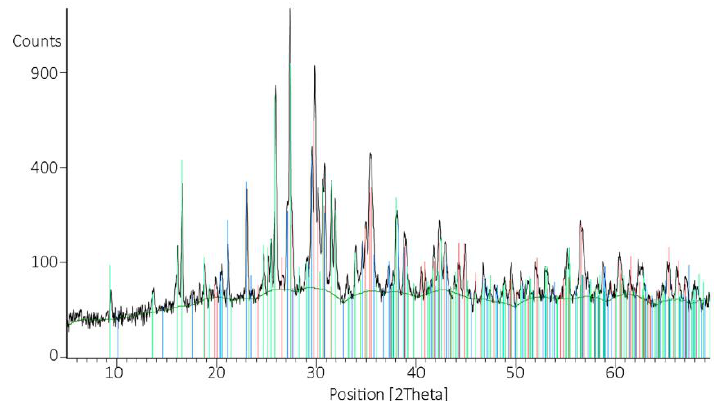
Figure 9. X-ray diffraction results from sample 9113B. The diffraction maxima allow the following crystalline phases to be identified: leucite (L) (green), nepheline (N) (blue) and diopside (D) (red) from the group of pyroxenes, in 42%, 26% and 32%, respectively. In volcanic materials the presence of significant amounts of amorphous phases (volcanic glass) means that the semi-quantitative values found for crystalline phases account only for their relative proportions.